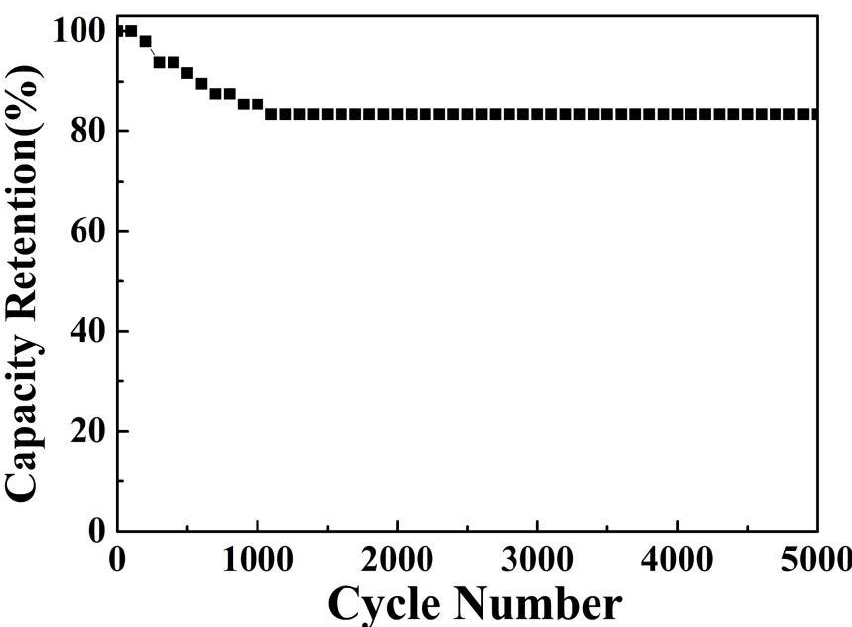
Figure 11. Cycling performance of the Cu(OH) 2 /Ni 3 S 2 electrode.